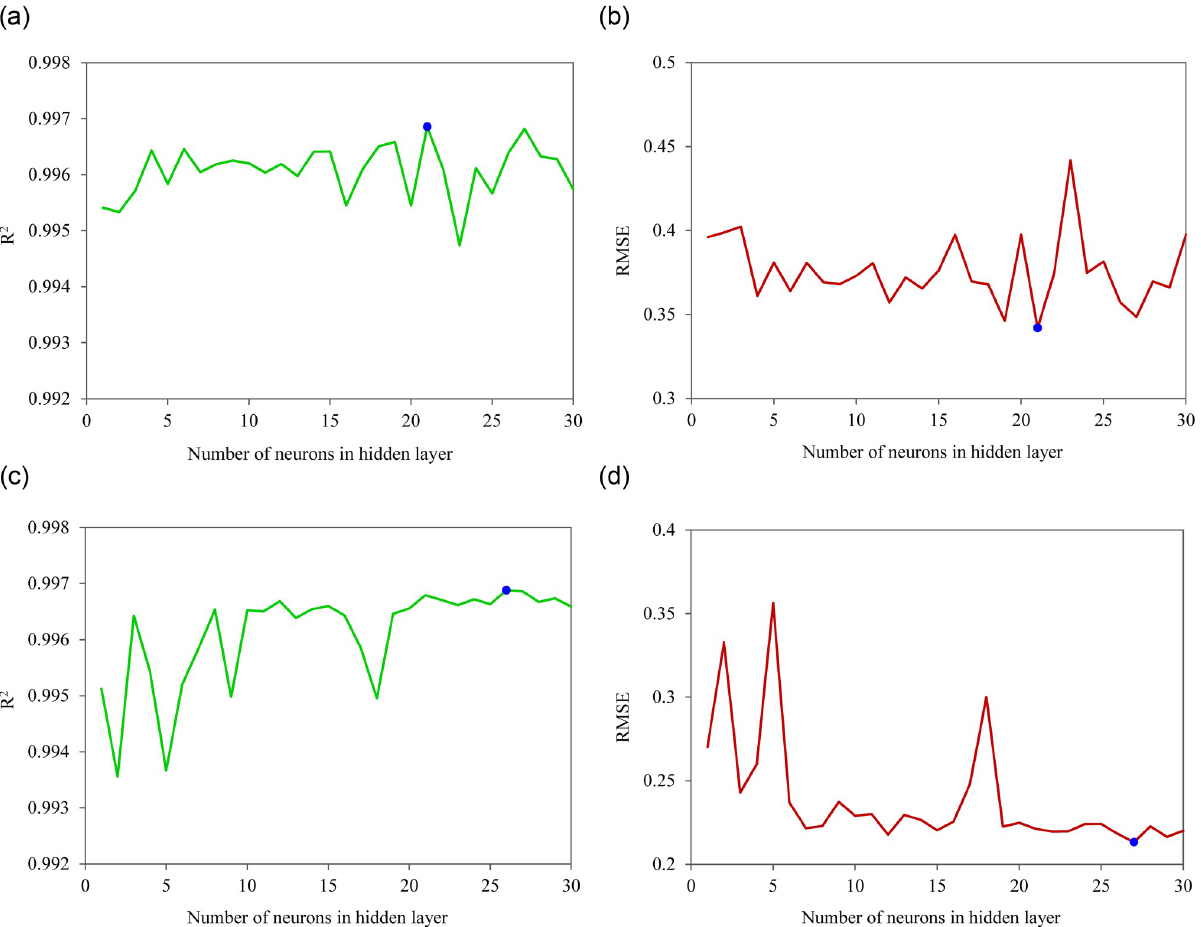
Fig 8. Performance criteria for ANN models with different numbers of neurons in the hidden layer, a) variation of the R 2 value of the LM-LS-21 model for 2019 data, b) variation of the RMSE value of the LM-LS-21 model for 2019 data, c) variation of the R 2 value of the LM-LS-27 model for 2021 data, d) variation of the RMSE value of the LM-LS-27 model for 2021 data.